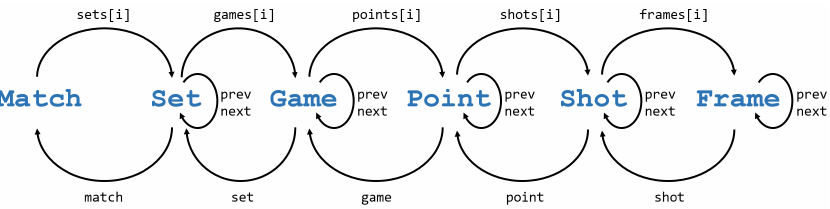
Figure 7. Main temporal units (Python classes) in our API, and methods/properties connecting